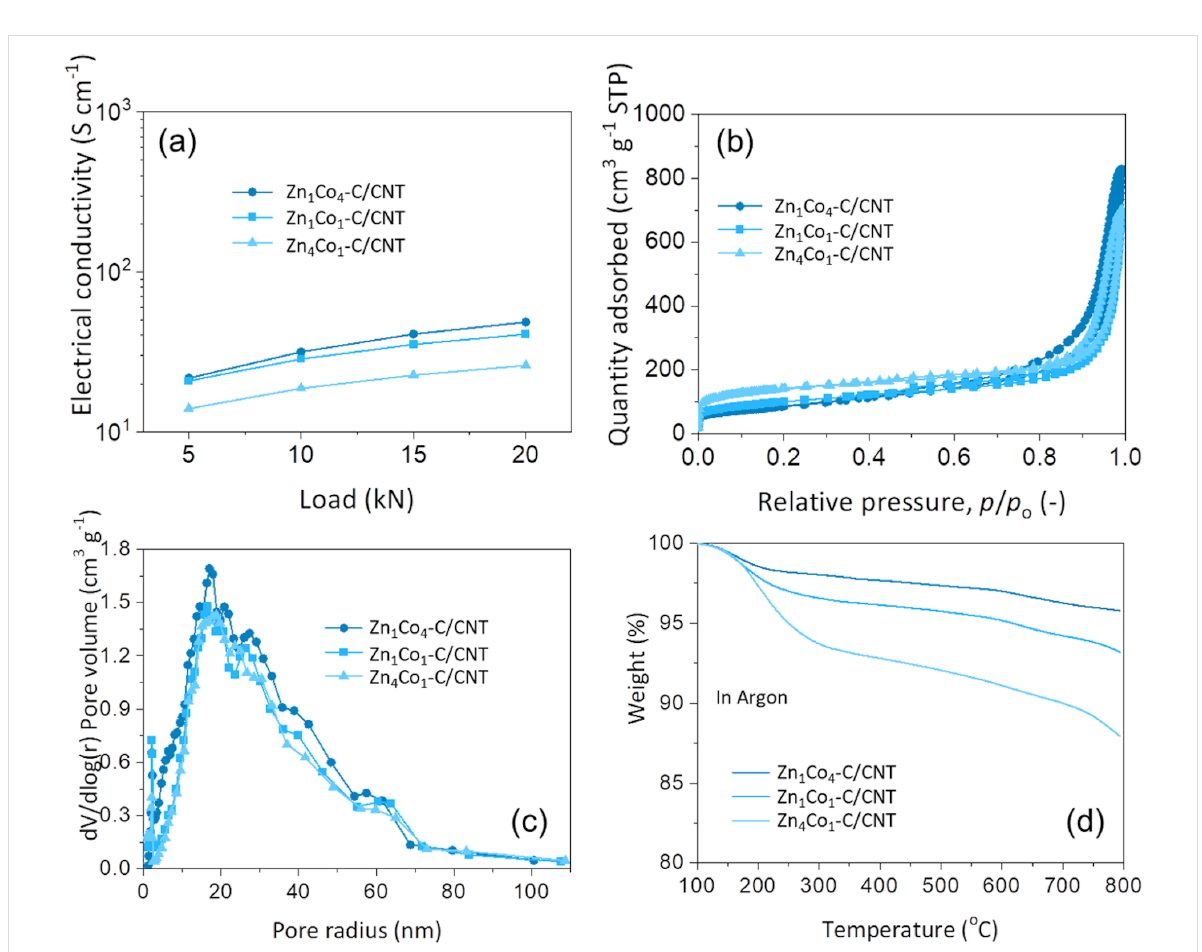
Figure 5: (a) Electrical conductivity, (b) N 2 sorption isotherms, (c) Dollimore–Heal desorption pore size distributions, and (d) TGA curves of Zn x Co y